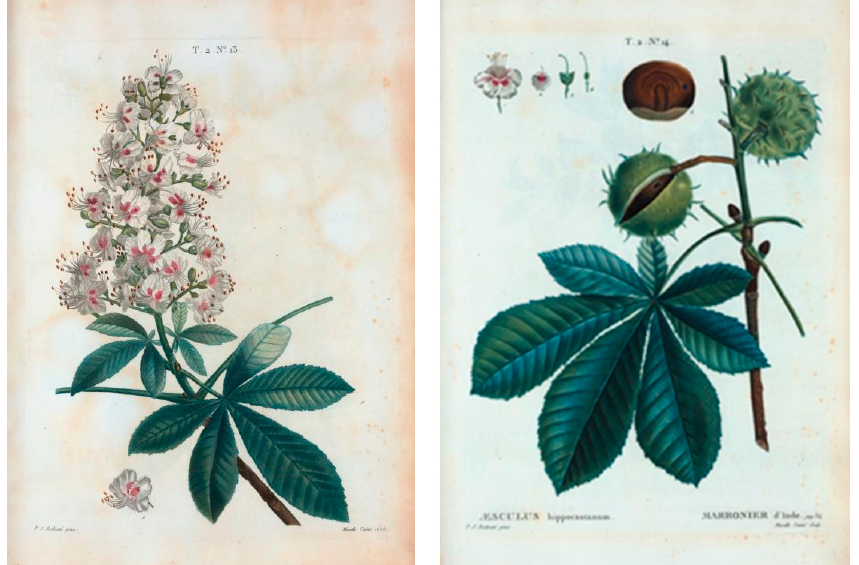
Figure 14. Duhamel du Monceau (France 1700–1782), Redout é , Pierre Joseph, (France 1759–1840), Trait é des arbres et arbustes que l’on cultive en France en pleine terre (Paris: Duhamel du Monceau 1801), Rare Book Division, The New York Public